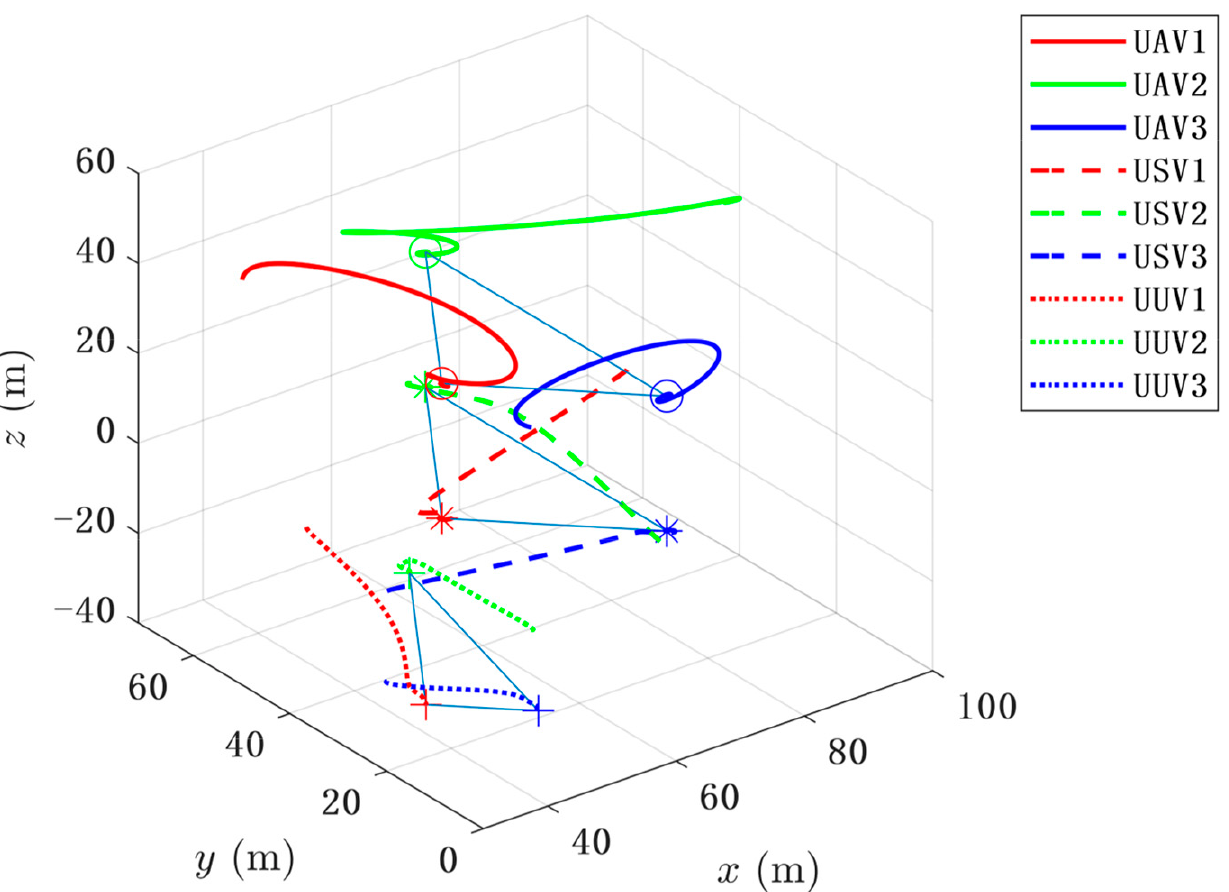
Figure 3. Formation state with static formation